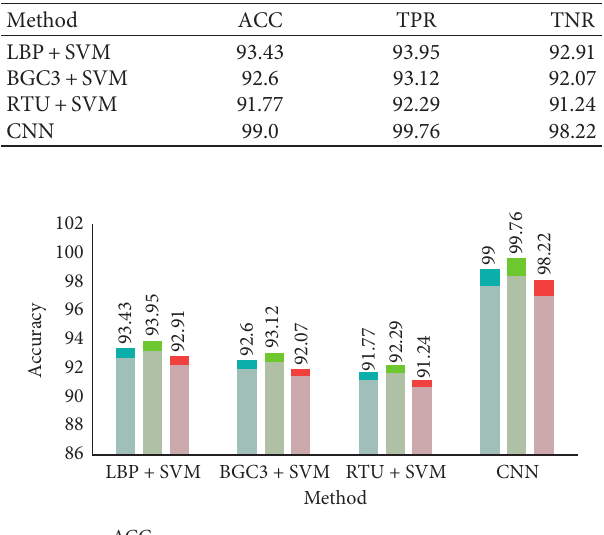
Table 2: Static texture recognition results.